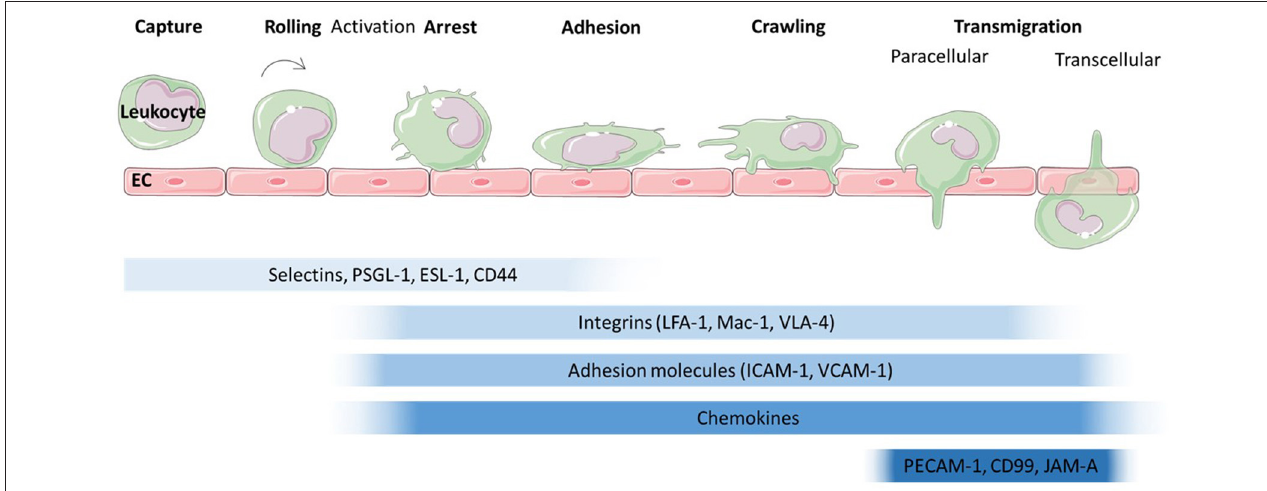
FIGURE 2 | Leukocyte migration cascade across endothelium. The leukocyte migration cascade comprises of a sequence of steps which are mediated by a range of proteins. The initial steps of capture and rolling are dominated by the interaction of selectins with proteins such as P-selectin glycoprotein ligand (PSGL)-1, E-selectin ligand (ESL)-1 and Cluster of differentiation (CD) 44. Activation leads to a conformational change in integrins such as lymphocyte function-associated antigen (LFA)-1, Macrophage (Mac)-1 antigen and Very Late Antigen (VLA)-4 which then interact with adhesion molecules such as Intercellular Cell Adhesion Molecule (ICAM-1) and Vascular Cell Adhesion Molecule (VCAM)-1. Together with chemokines presented on the endothelial surface, arrest and adhesion are triggered. The final step, transmigration through the endothelial cell layer is mediated by proteins such as platelet endothelial cell adhesion molecule (PECAM) − 1, CD99 and junctional adhesion molecule (JAM)